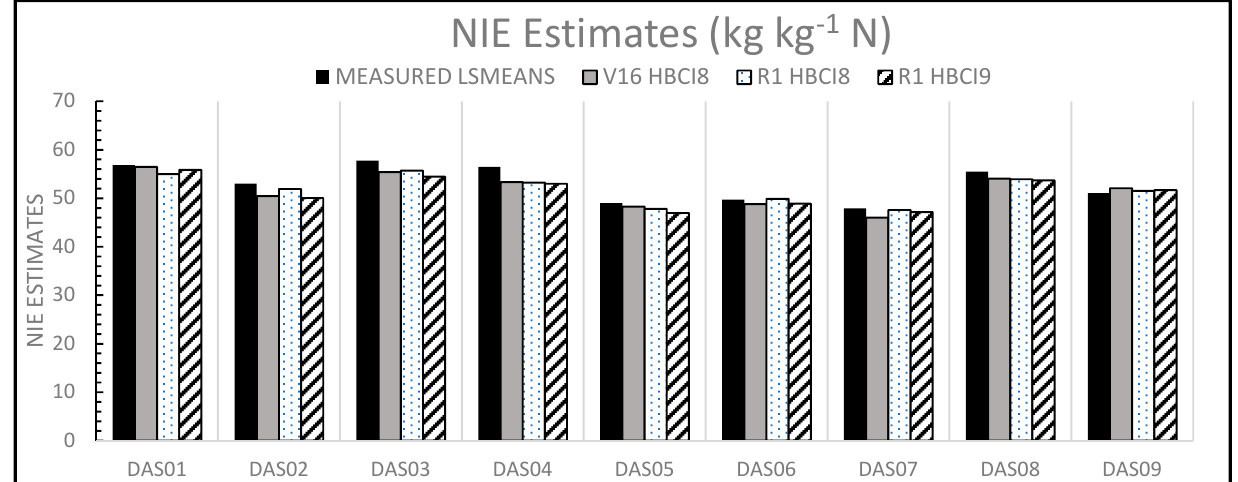
Figure 7. Least square means estimates of NIE by hybrid based on measured or HSI models.